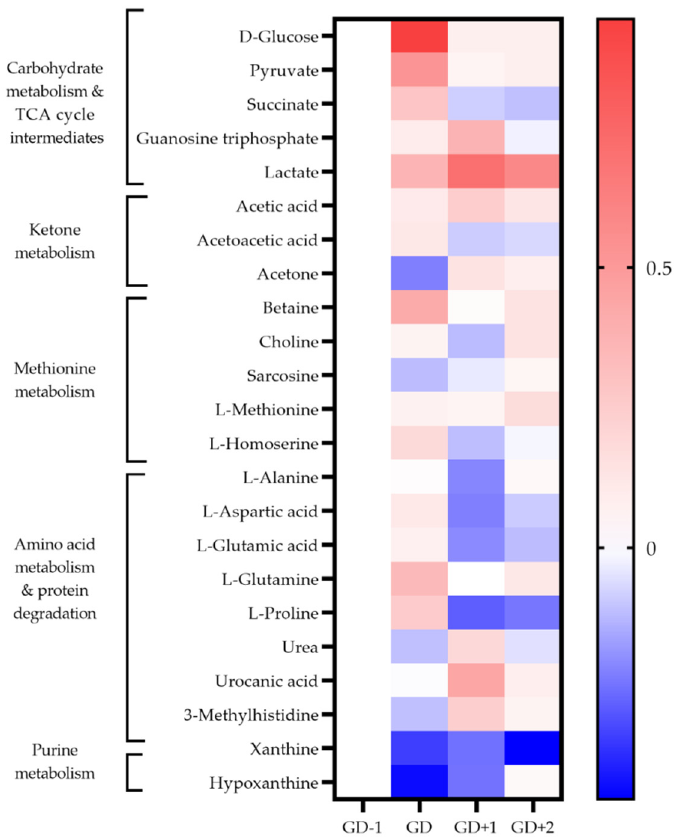
Figure 3. Heatmap of metabolites identified as key discriminators between timepoints via PLSDA modelling in saliva samples. The fold change calculated from the GD − 1 sample is displayed as the natural logarithm to indicate an increase (greater than 0, red) or decreased (less than 0, blue).